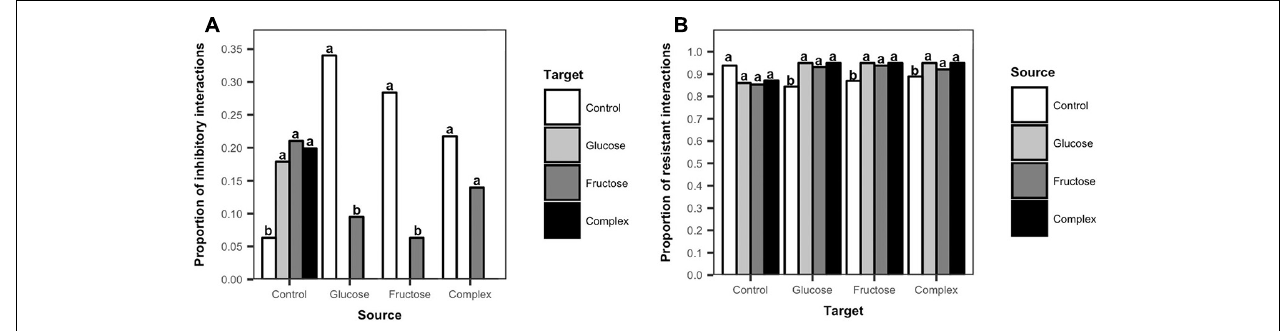
FIGURE 4 | Frequency of inhibitory and resistant interactions among Streptomyces isolates from carbon-amended and non-amended soils. Each bar represents the mean proportion of inhibitory interactions among source Streptomyces isolates ( n = 10) that were inhibitory against target Streptomyces isolates ( n = 10) from different treatments (A) , or the mean proportion of resistant interactions among target Streptomyces isolates ( n = 10) that resisted inhibition by source Streptomyces isolates ( n = 10) (B) . Inhibitory interactions were determined by the presence and size of complete inhibition zones ( > 2 mm) representing the lack of growth of a target isolate in association with a source isolate on agar plates. Resistant interactions were determined by the presence and size of incomplete inhibition zones ( < 2 mm) representing the growth of a target isolate and the lack of inhibition by a source isolate on agar plates. Different letters above the bars indicate significant differences among treatments of source isolates ( Figure 4A ) and within treatments of target isolates ( Figure 4B ). Bars sharing at least one letter are not significantly different from each other (ANOVA and LSD test, p <